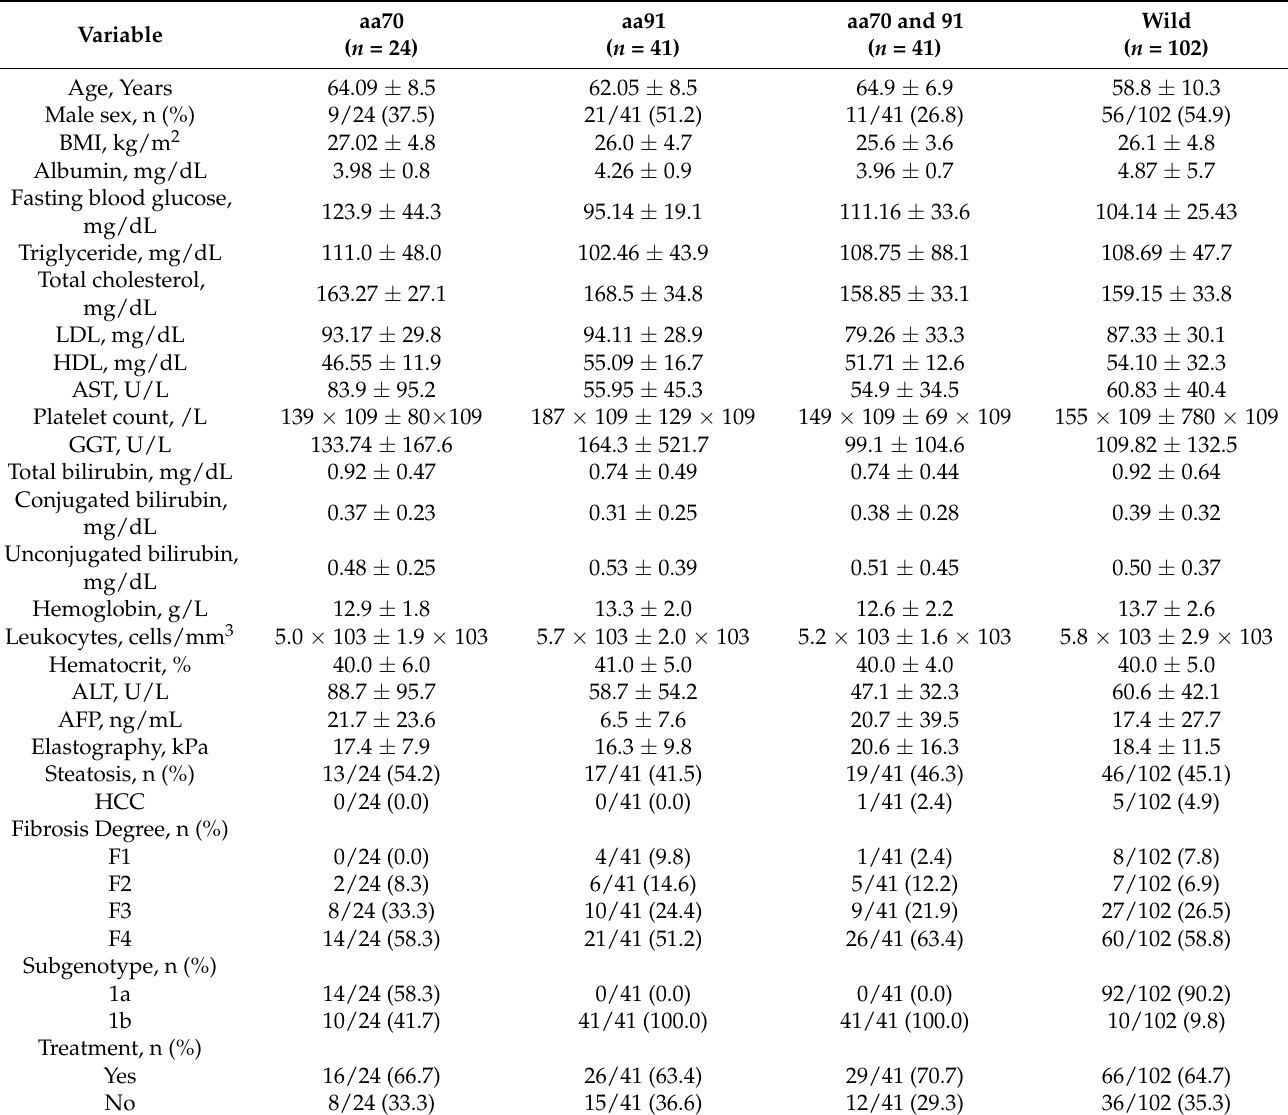
Table 2. Demographic, biochemical, and histological characteristics of chronic hepatitis C patients with different substitutions in the core region (mean ± SD and case